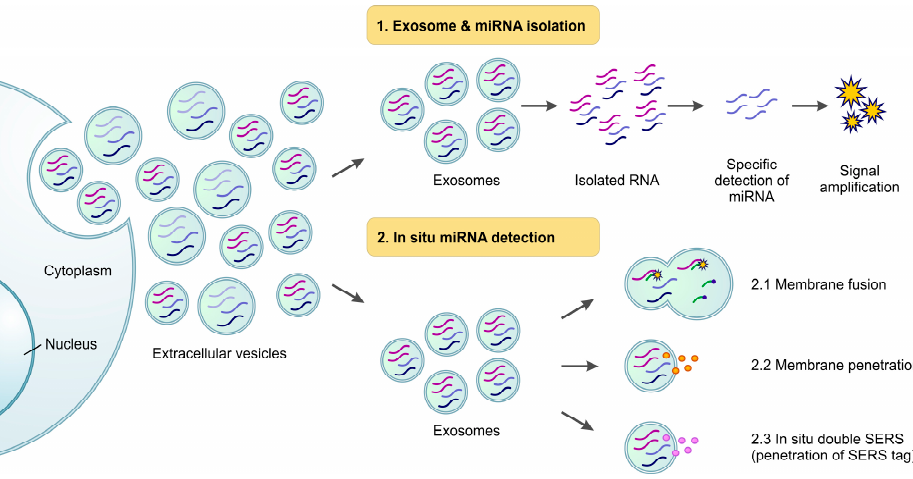
Figure 4. Detection of exo-miRNAs in clinical samples.